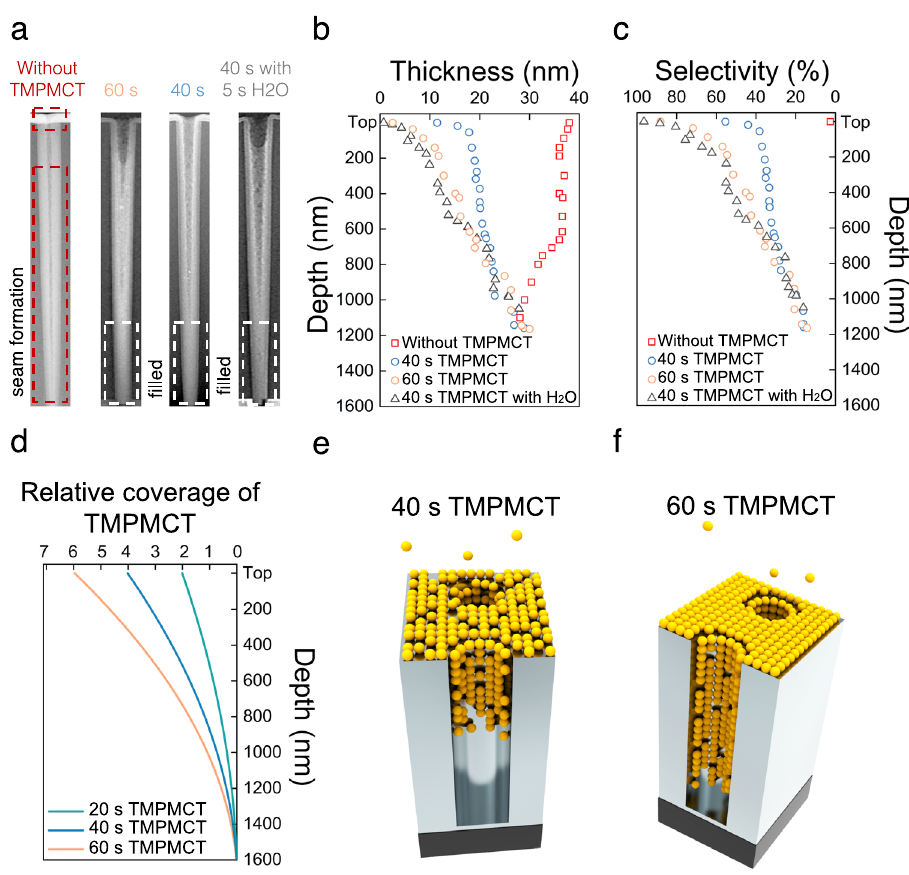
c selectivity calculated from the TEM results. d Relative coverage of various TMPMCT pulses, as calculated from the equation described in Supplementary Note 3 and depicted in illustrations e 40s TMPMCT pulse, f 60s TMPMCT pulse. Source data are provided as a Source data fi